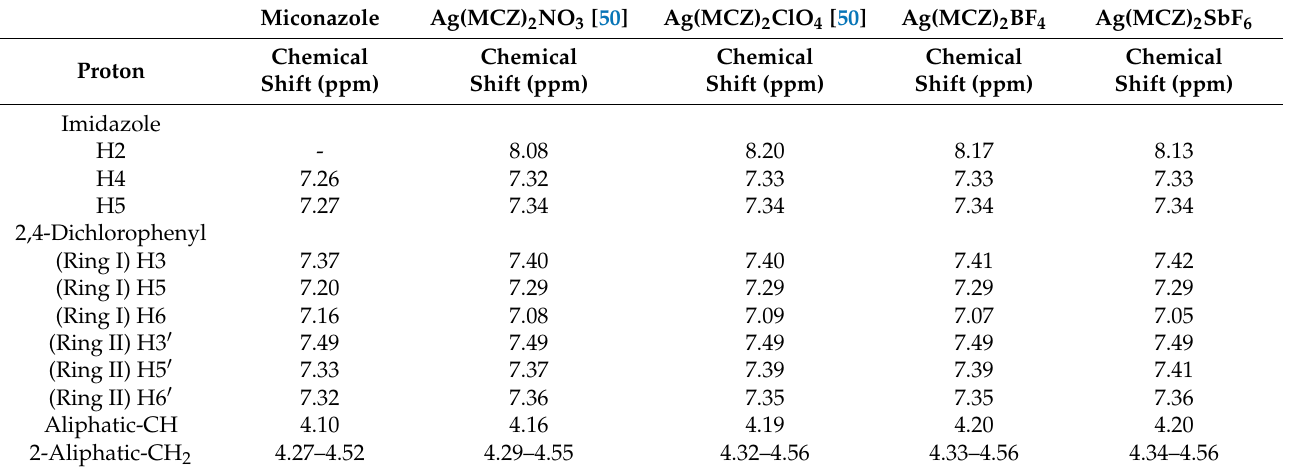
Table 1. Proton chemical shifts in ppm for miconazole and complex compounds at room temperature in CDCl 3 .